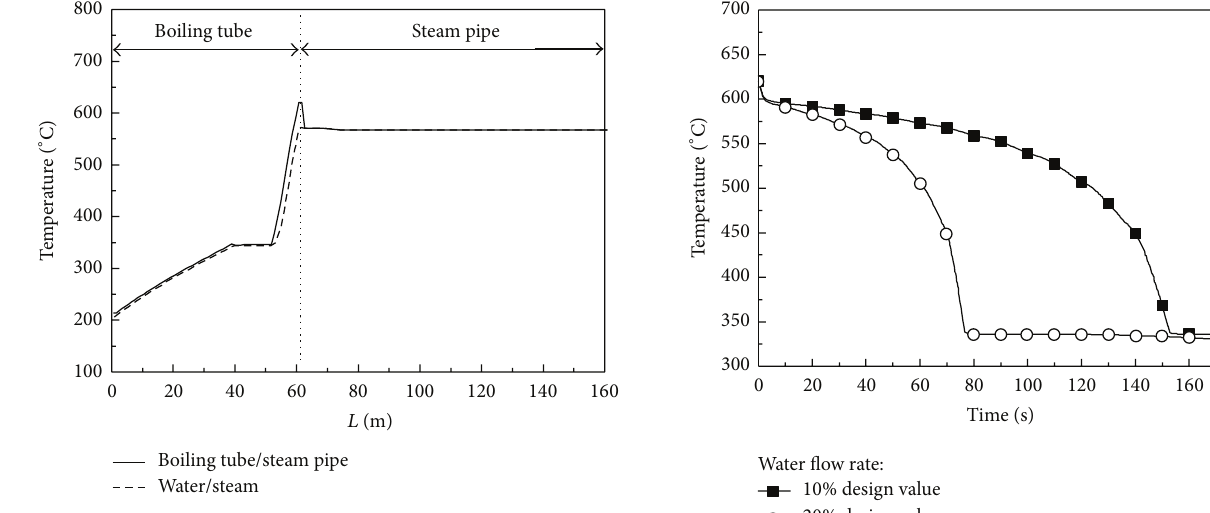
Figure 5: Temperature distribution of boiling tube and steam pipe after shutdown of the core. Figure 6: Temperature transient of boiling tube (steam outlet) during delay time; helium flow rate: 0; feed water temperature: 105 ∘ C; and pressure: 13.9 MPa.